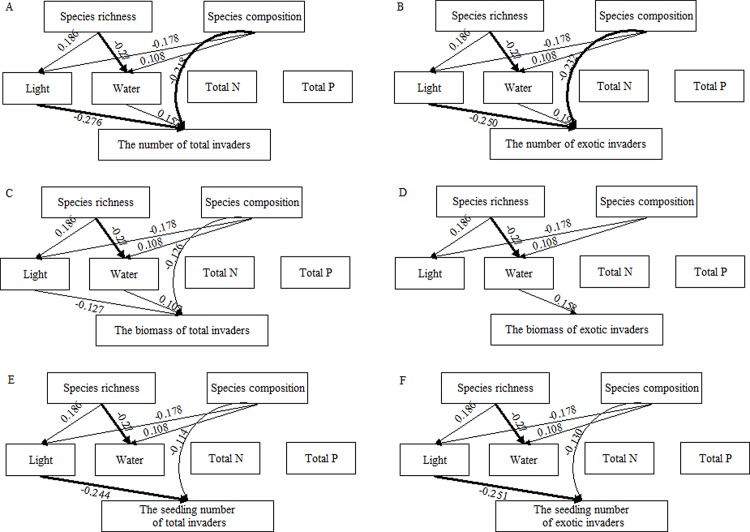
The final structural equation models for species number (A, B), biomass (C, D) and seedling number (E, F) of total and exotic invaders.Values on arrows represent standardized regression coefficients. Continuous arrows, in the structural part of the model, are significant relationships (P < 0.05); The arrows not significant are eliminated (P > 0.05). The size of the arrows is proportional to the strength of the path. The significant relationships of species composition only indicate significant effect on invasion, and the “-” did not indicate a negative effect.